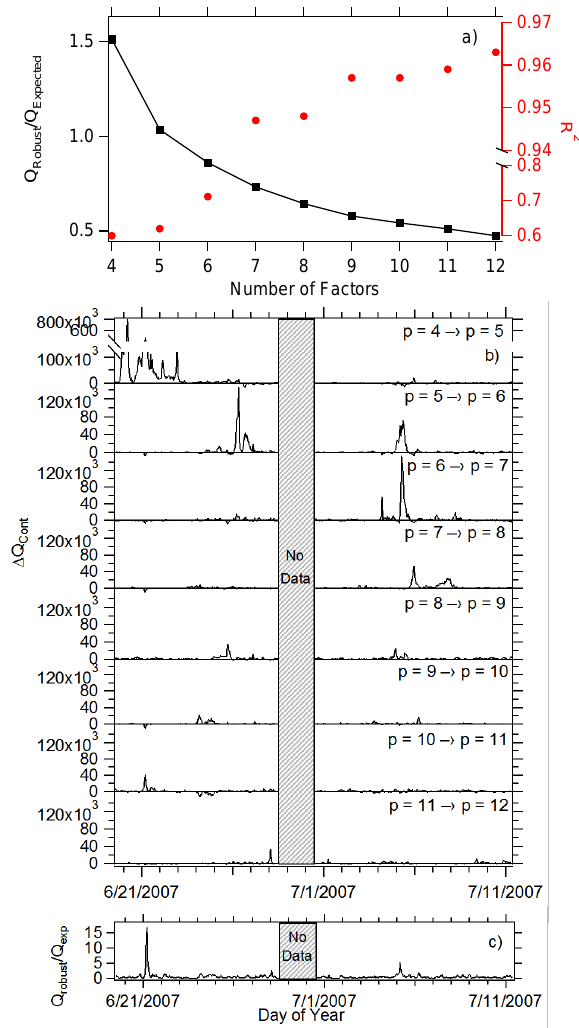
Fig. 4. The impact of increasing the number of factors ( p ) in a PMF solution on the R 2 and robust Q value (a) ; the incremental change in time-dependent contribution of the residuals to the Q value upon addition of factors ( 1Q cont ) (b) ; and the time-dependent contribu- tion of the robust Q value normalized to the expected Q value for the 9 factor solution (c)